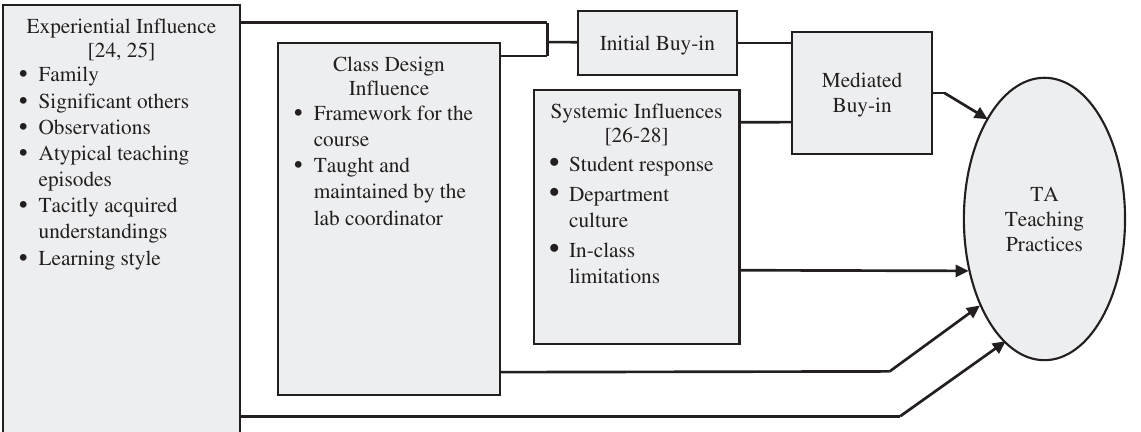
FIG. 1. A schematic of the influences on a TA ’ s teaching practices. The interaction of the experiential and class design influences is where initial buy-in is lost or gained. Initial buy-in may change based on systemic influences leading to a mediated